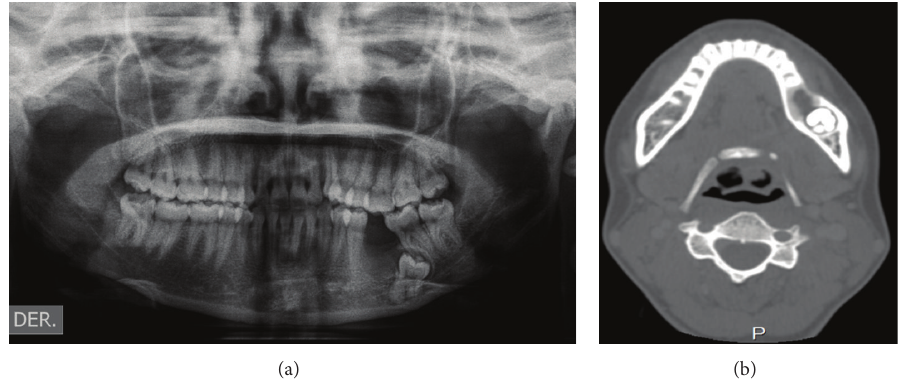
Figure 4: Panoramic radiograph (a) and axial CT scan (b) revealing an ill-defined radiolucent lesion around an impacted mandibular left first